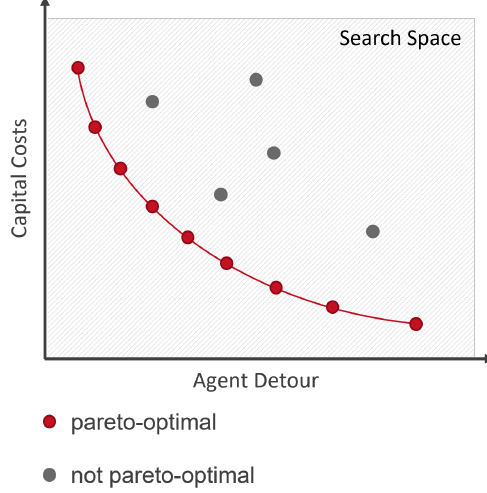
Figure 2. Qualitative representation of a Pareto